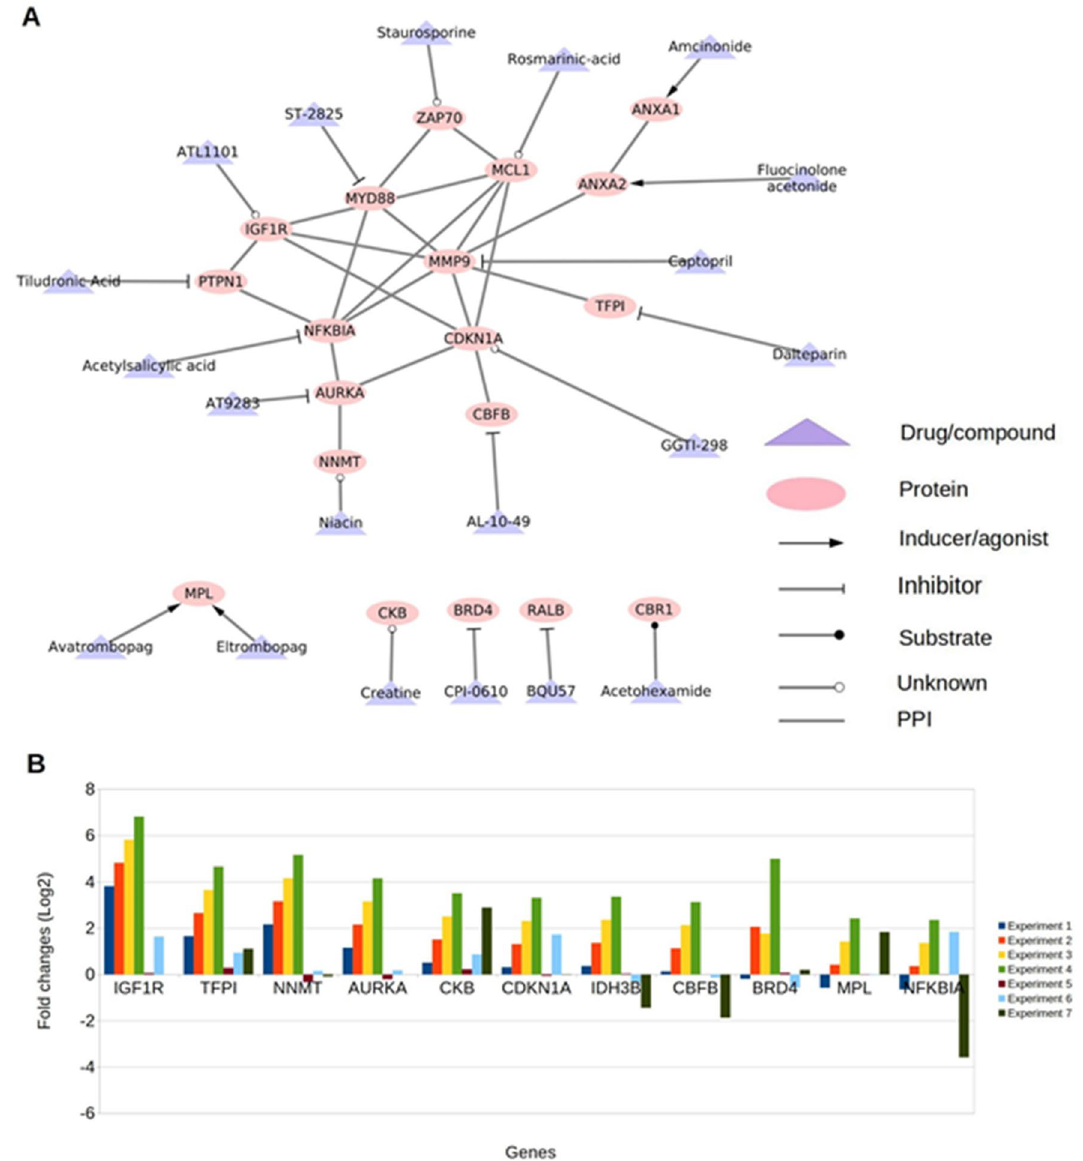
Figure 5. Drug-target network of potential targets and gene expression. ( A ) drug-target network. PPI = protein–protein associations obtained using STRING database.The network was created using Cytoscape version 3.7.2 15 . ( B ) Fold changes of genes showing consistent differential expression of mice in high radiation doses (i.e., 10 Gy and 12 Gy) from GSE10640, GSE6874, and GSE104121. Experiment 1 and 2 were from BLK mice 24 h post-irradiation with 10 Gy, Experiment 3–6 were from BalbC (3,5,6) and BLK (4) 6hrs post- irradiation with 10 Gy, and Experiment 7 was performed on BalbC mice 6hrs post-irradiation with 12 there were multiple species of mice used (Balbc and Blk); hence, differential expression was performed between healthy Balbc vs. Irradiated and similarly for the Blk mice. A total of 32 comparisons for differential expression analysis were performed across all five datasets (Supplementary Data 5). Two-fold change was considered as a significant differential expression. Weighted gene coexpression network construction. Prior to the construction of the network, data- sets were quantile normalized using the limma package in R. Next, genes were filtered based on the coefficient of variation (CV) to remove spurious correlations among genes. A total of five networks were constructed consist- ing of two human (one from GSE10640 one from GSE6874), and three mice networks (GSE10640, GSE6874, GSE104121). Pearson’s correlation coefficient between genes within each dataset. Assuming the biological networks show scale-free topology, the absolute correlation between genes was raised with a soft thresholding